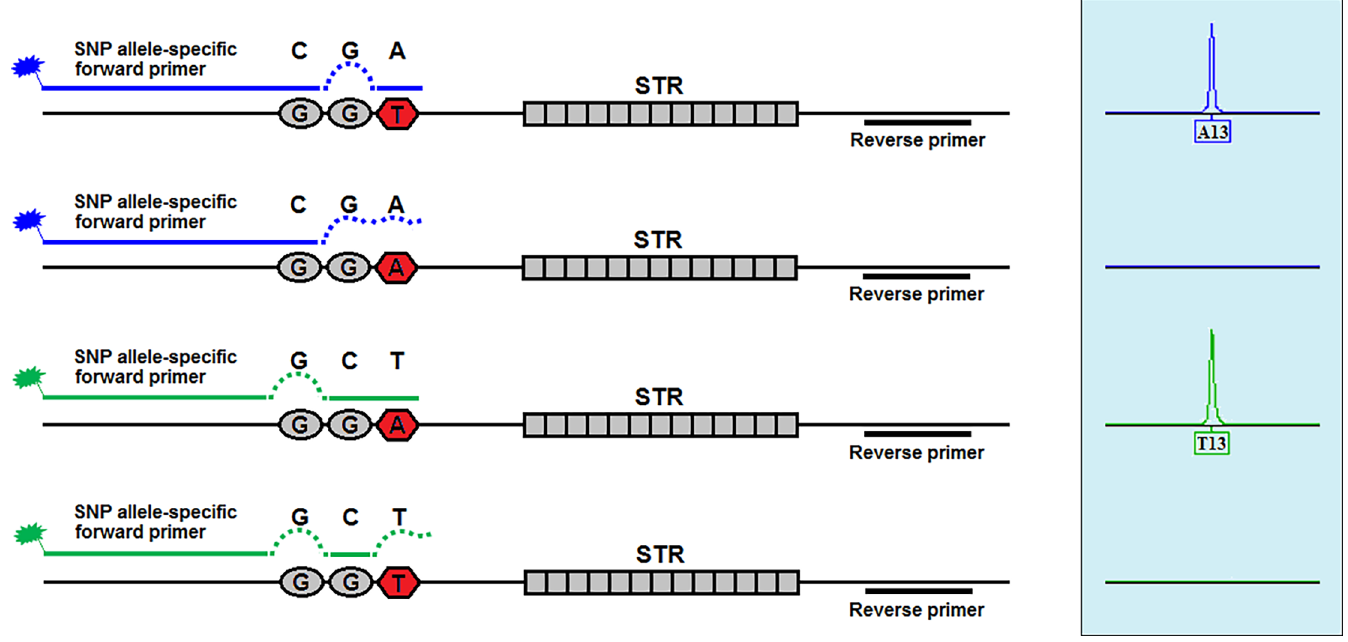
Fig 1. Schematic diagram of SNP-STR typing based on the principle of ARMS-PCR.